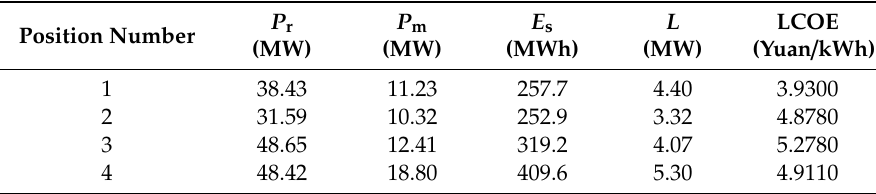
Table 4. Optimal sizing results. P r : wind turbine rated power, P m : PV array installed capacity, L : load, and LCOE: levelized cost of